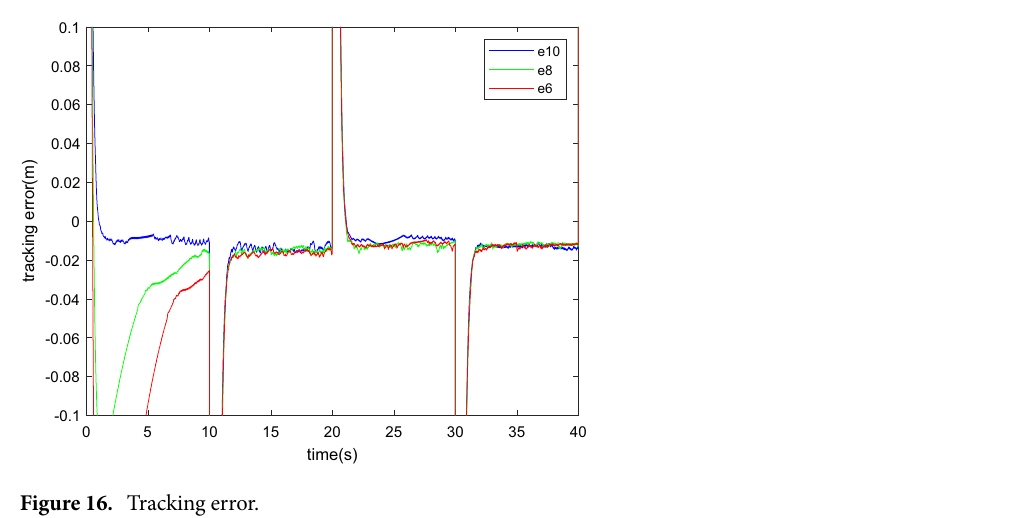
Figure 16. Tracking